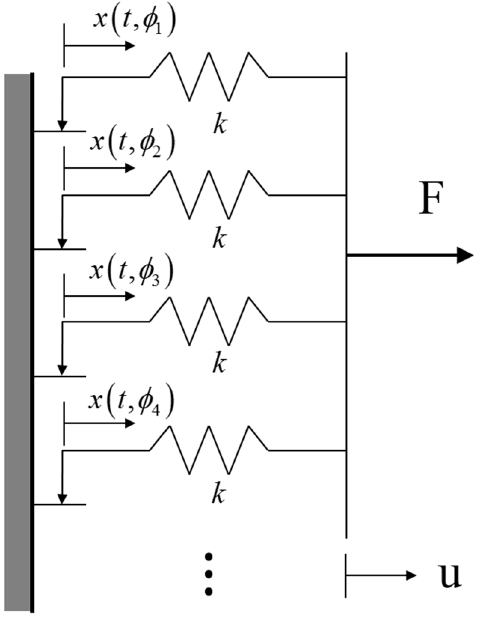
Figure 1. Description of the parallel-series Iwan model.